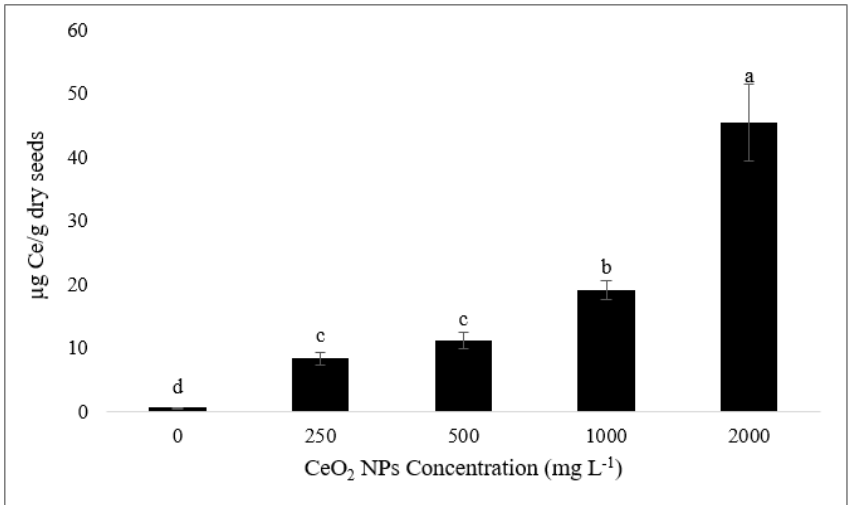
Figure 5. Cerium concentration in seeds harvested from bean plants treated aerially with different nCeO 2 suspensions compared to control. Data are means ± SE. Different letters represent statistical differences at p ≤ 0.05.